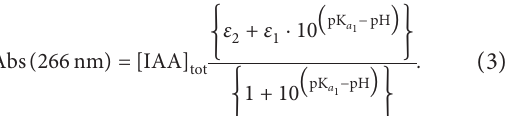
Figure 3: Dependencies of k ionic strength for reduction of [IrCl 6 ] 2– by ° C and 1.0M obsd on [AA] tot at 25.0